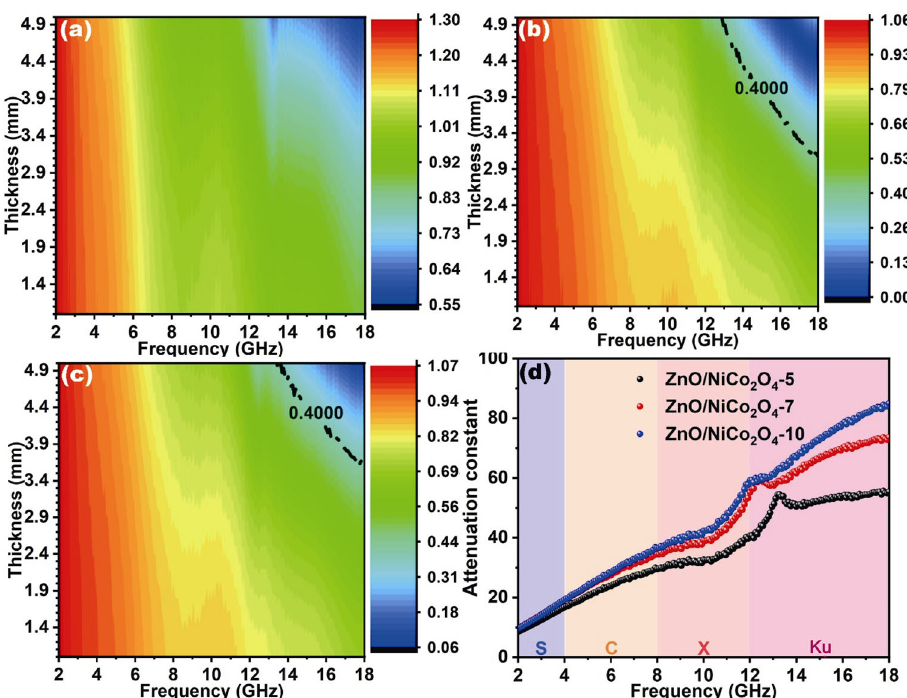
Fig. 7 (a–c) Color maps of the Δ : (a) ZnO/NiCo 2 O 4 -5; (b) ZnO/NiCo 2 O 4 -7; (c) ZnO/NiCo 2 O 4 -10; and (d) α values of ZnO/NiCo 2 O 4